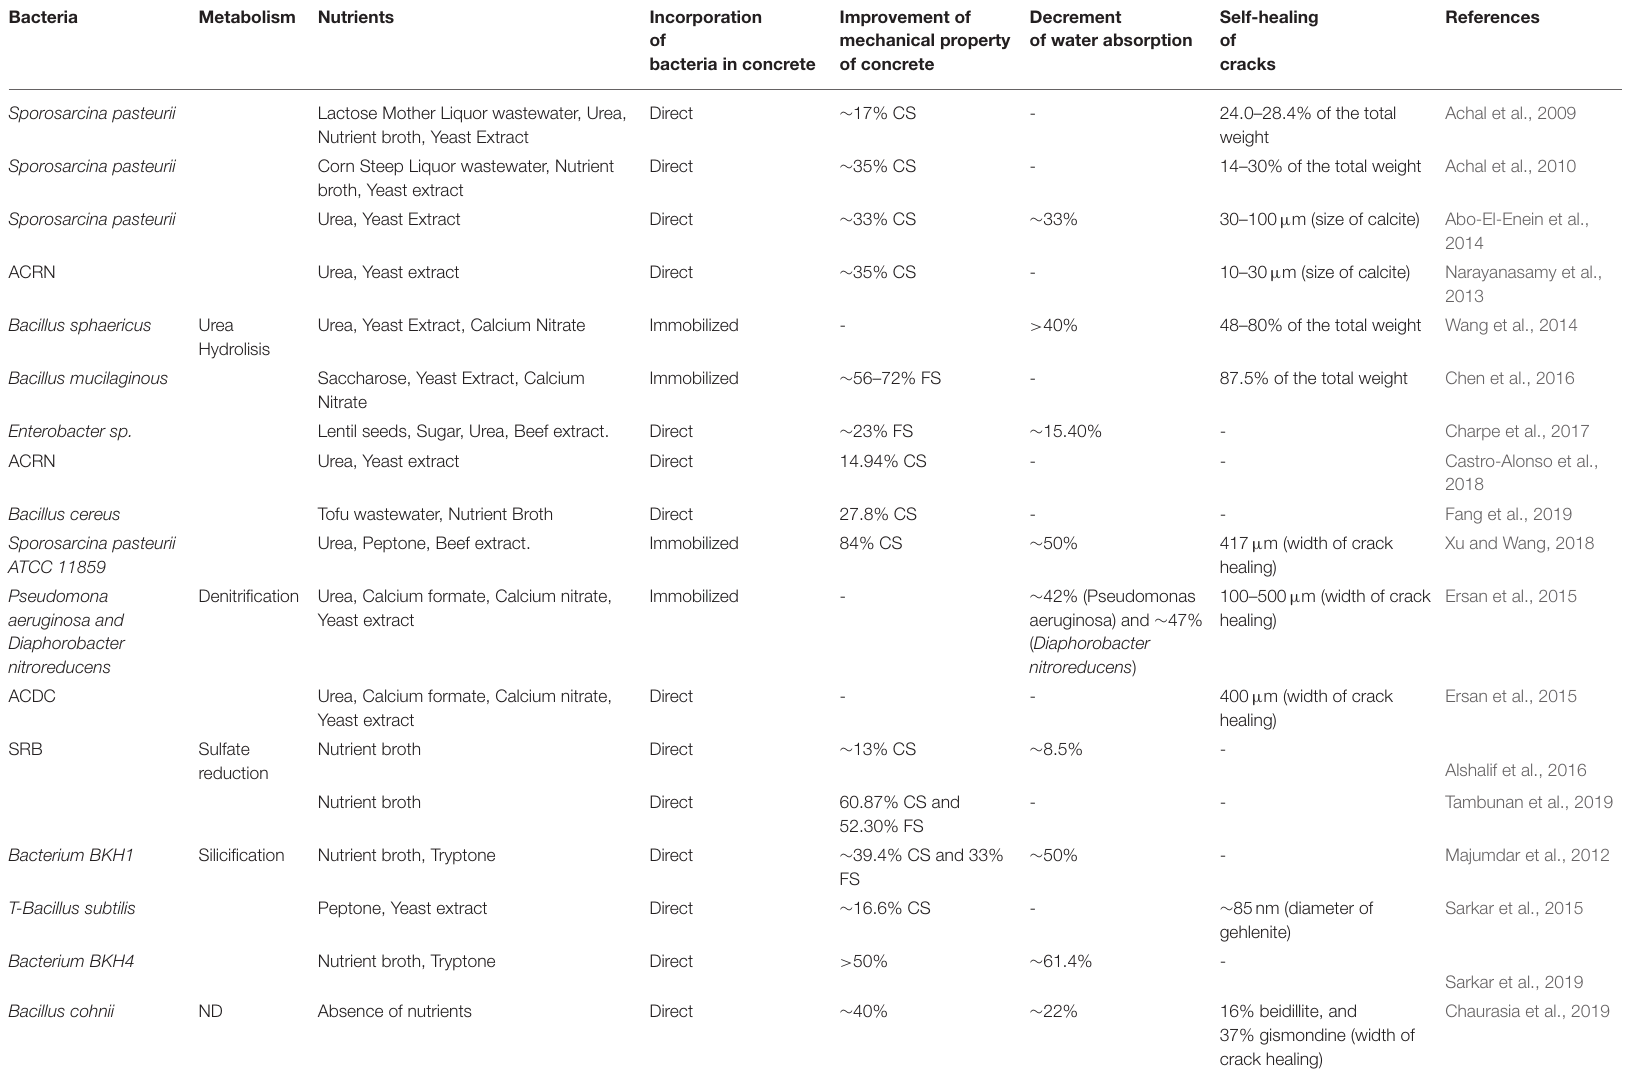
TABLE 1 | Nutrients and their effect on compressive strength, flexural strength, water permeability, and self-healing of bioconcrete